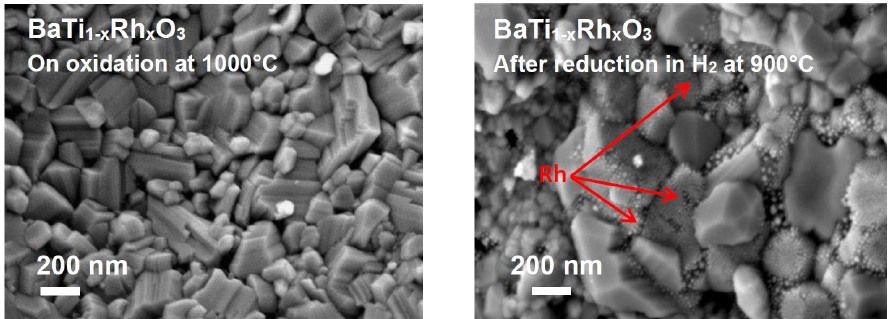
Figure 6. ( Left ) SE micrograph of the BaTi 0.95 Rh 0.05 O 3 catalytic filter after calcining at 1000 ˝ C in air and ( Right ) after reducing treatment at 900 ˝ C under 2.5 vol.% H 2 in argon, displaying the segregation of Rh nanoparticles.